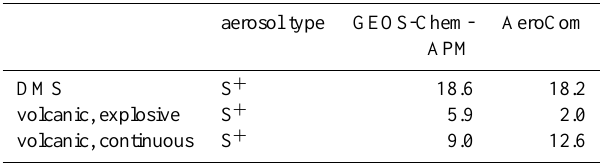
Table 3. Natural sulfur (S + ) emissions from GEOS-Chem-APM and comparison with AeroCom. Unit: Tgyr −